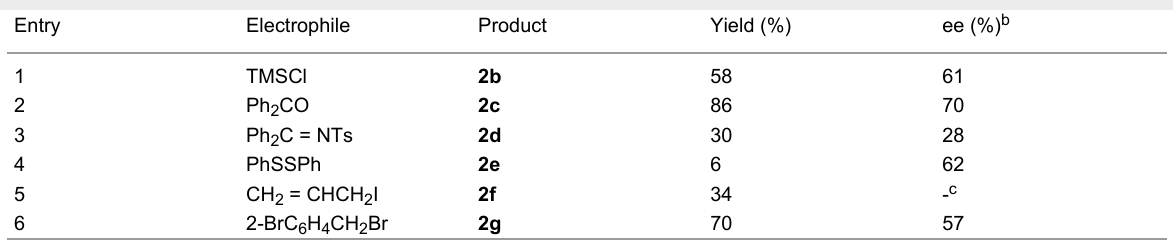
a Reactions were performed using sulfoximine 1b and an excess of lithium amide 5 at -105°C in THF see Supporting Information File 1 for experi- mental details b Determined by HPLC using a chiral column. c Not determined